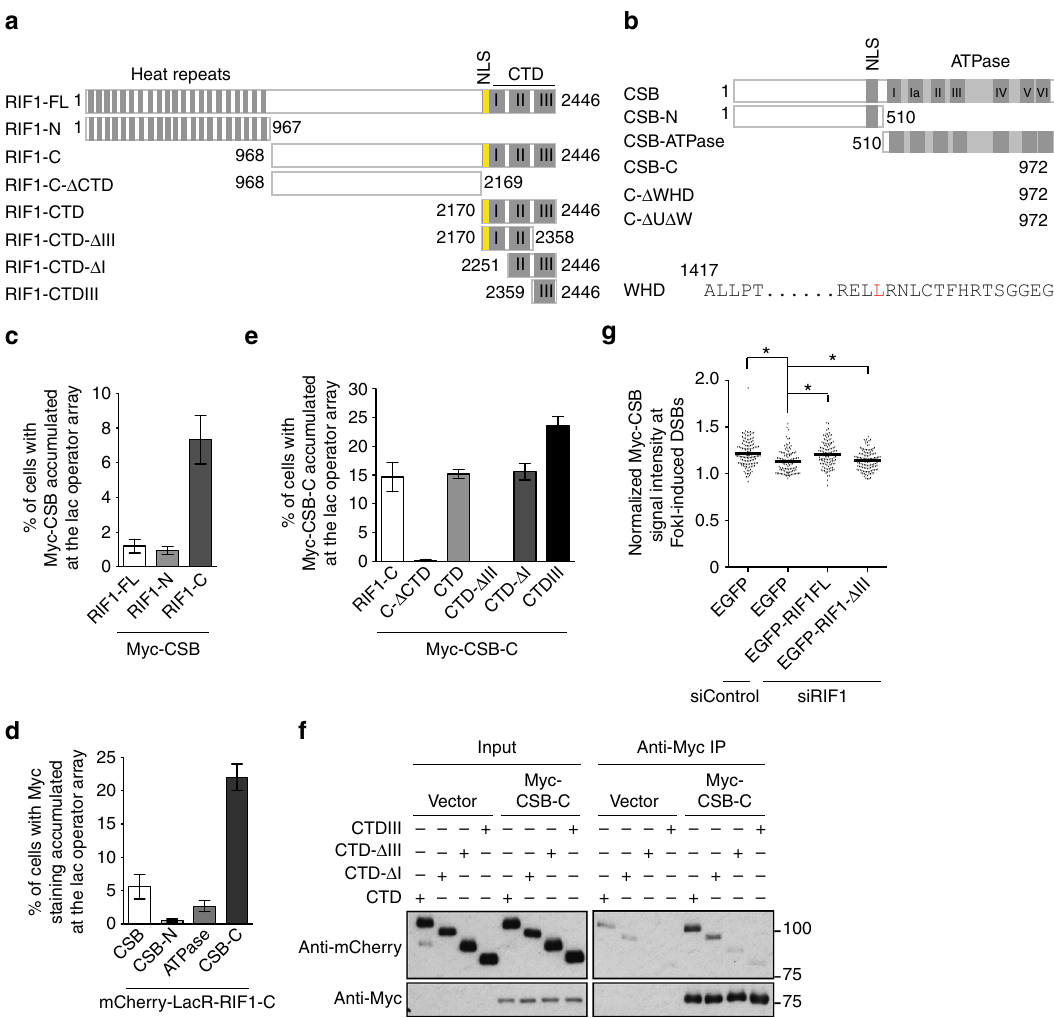
Fig. 2 RIF1 interacts with CSB and recruits CSB to DSBs via its CTD domain. a Schematic diagram of RIF1. NLS: nuclear localization signal; CTD: C-terminal domain. b Schematic diagram of CSB. c Quanti fi cation of the percentage of cells exhibiting Myc-CSB accumulated at the lac operator array. U2OS-265 cells were co-transfected with Myc-CSB and various mCherry-LacR-RIF1 alleles as indicated. A total of 250 cells positive for Myc-CSB expression were scored for each independent experiment in a blind manner. SDs from three independent experiments are indicated. d Quanti fi cation of the percentage of cells exhibiting Myc staining accumulated at the lac operator array. U2OS-265 cells were co-transfected with mCherry-LacR-RIF1-C and various Myc-tagged CSB alleles as indicated. A total of 250 cells positive for expression of various Myc-tagged CSB alleles as indicated were scored for each independent experiment in a blind manner. SDs from three independent experiments are indicated. e Quanti fi cation of the percentage of cells exhibiting Myc-CSB-C accumulated at the lac operator array. U2OS-265 cells were co-transfected with Myc-CSB-C and various mCherry-LacR-RIF1-C alleles as indicated. A total of 250 cells positive for Myc-CSB-C expression were scored for each independent experiment in a blind manner. SDs from three independent experiments are indicated. f Coimmunoprecipitation with anti-Myc antibody in 293T cells expressing the vector alone or Myc-CSB-C in conjunction with various mCherry-LacR-CTD alleles as indicated. Immunoblotting was done with anti-Myc and anti-mCherry antibodies. g Quanti fi cation of the intensity of Myc- CSB signal at the site of FokI-induced DSBs. 24 h post transfection with siControl or siRIF1, U2OS-265 cells were transfected with the EGFP vector alone or various siRIF1-resistant EGFP-RIF1 alleles as indicated and induced for FokI expression 48 h post transfection. Analysis of Myc-CSB signal intensity was only done for cells positive for expression of Myc-CSB, EGFP and mCherry-LacR-FokI. The respective numbers of cells analyzed for siControl/EGFP,